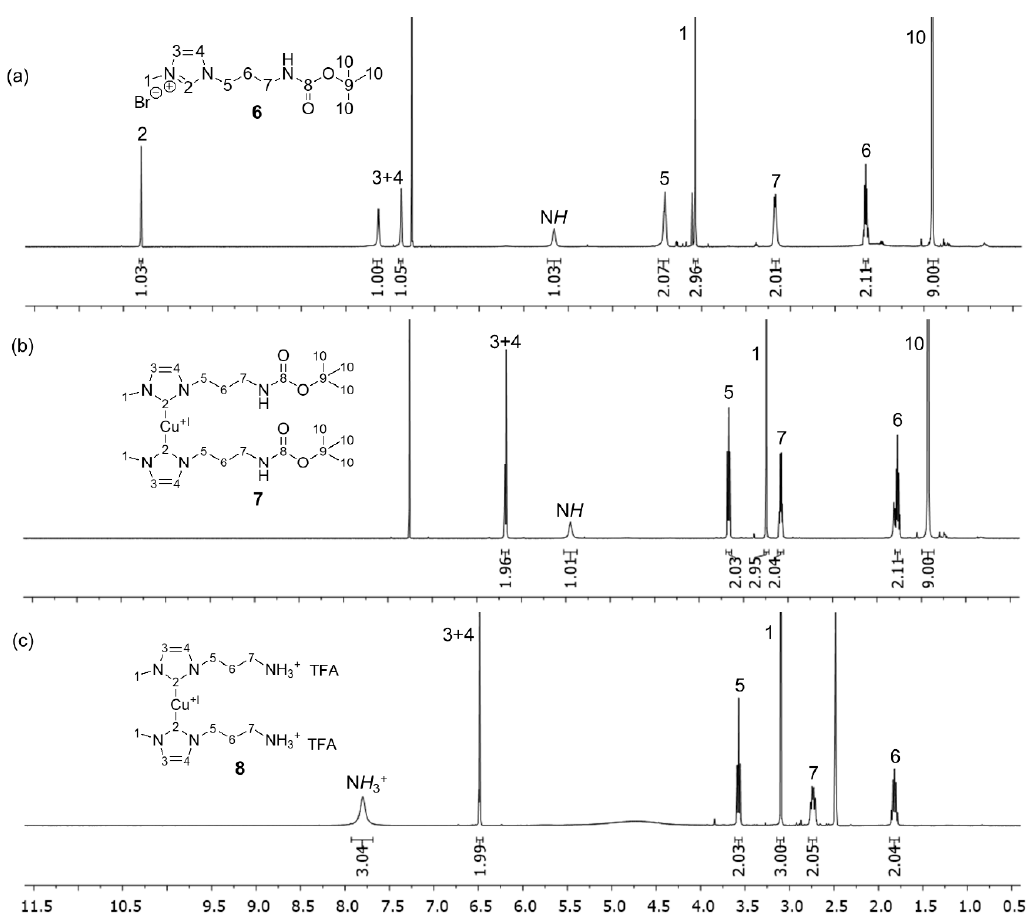
Figure 3. 1 H NMR spectra of ( a ) the NHC precursor 6 , ( b ) the Boc-protected complex 7, and ( c ) the deprotected complex 8 bearing two amino groups.